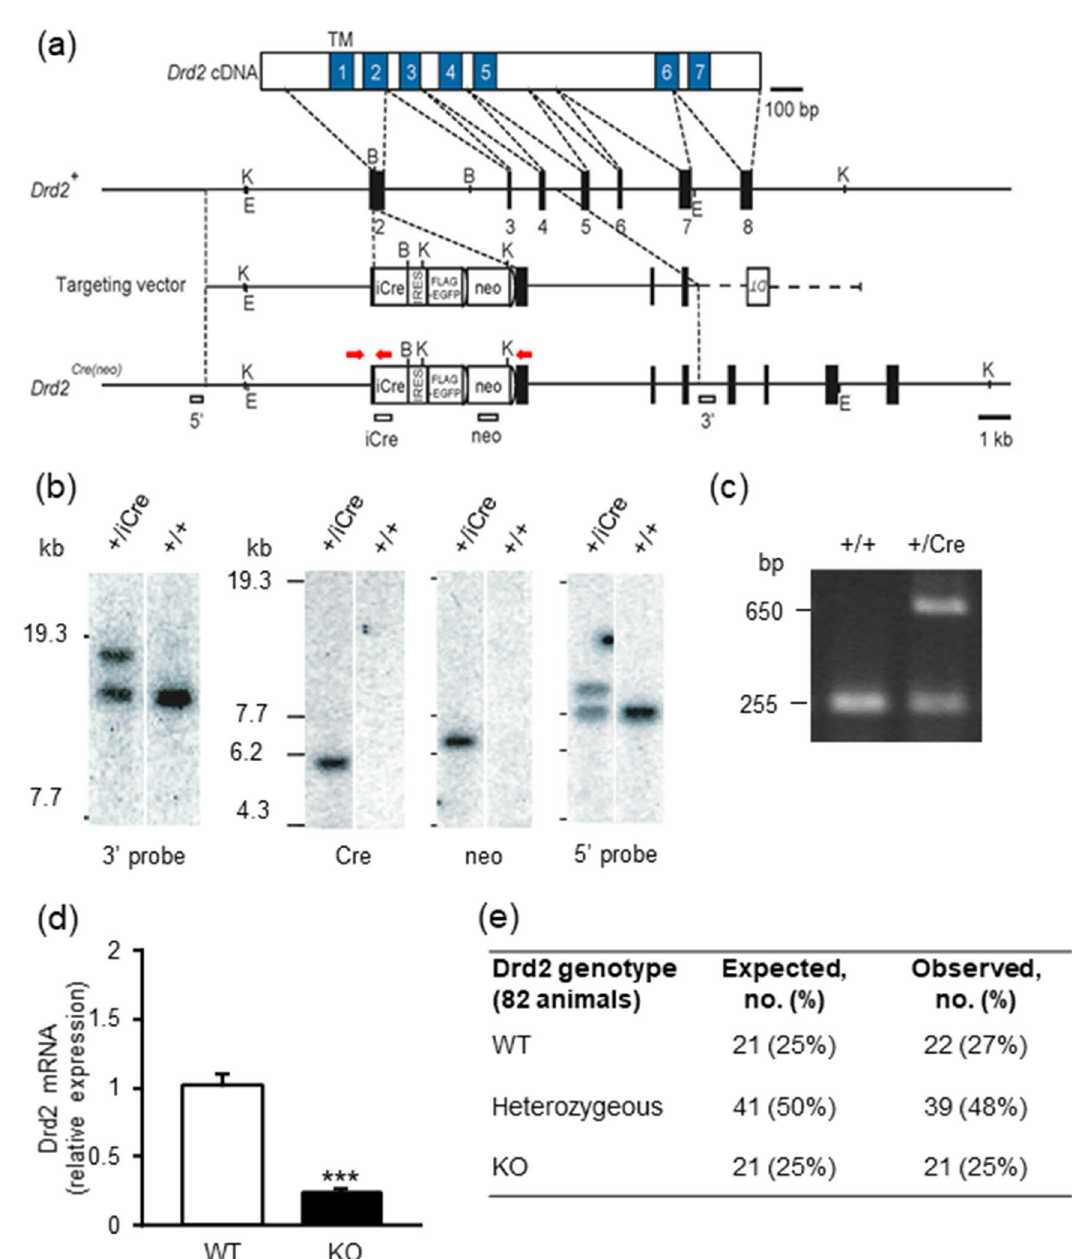
Figure 6. Generation of the Drd2-Cre mouse line. ( a ) Schema of Drd2 cDNA, genomic DNA, targeting vector and the targeted genome. Numbered blue boxes in cDNA are transmembrane domains, and black boxes indicate coding exons. The vector was constructed to insert an improved Cre recombinase gene ( iCre ), followed by an internal ribosome entry site ( IRES ) and a FLAG-tagged EGFP , into the translational initiation site of the Drd2 gene. Red arrows show primer positions for PCR genotyping. White boxes indicate probes for Southern blot analysis. Two frt sequences (semicircles) are attached to remove the neomycin resistance gene (Neo). B, Bam H1; E, Eco T22I; and K, Kpn I. ( b ) Southern blot analysis for genomic DNAs from wild-type (+ / +) and targeted (+ / iCre ) ES cells. The first panel from left shows Eco T22I-digested genomic DNA hybridized with 3 ′ probe, and the other three panels show Kpn I-digested DNA hybridized with Cre, Bam HI digested DNA, Neo and 5 ′ probes, respectively. Full-length images are available in Supplementary Fig. 1. ( c ) Genomic PCR genotyping of Drd2 + /iCre using Drd2 forward, reverse and Cre primers. Full-length images are available in Supplementary Fig. 2. ( d ) Expression of Drd2 mRNA in the hypothalamus of wild-type (WT) mice and Drd2 knockout (KO) mice. Each point represents the mean ± S.E.M. of 6–9 mice. *** P < 0.001 vs. WT group. ( e ) Observed genotypes of offspring of heterozygous intermatings, in comparison with expected genotypes calculated according to the total number of mice born (82 mice) and the expected Mendelian 1:2:1